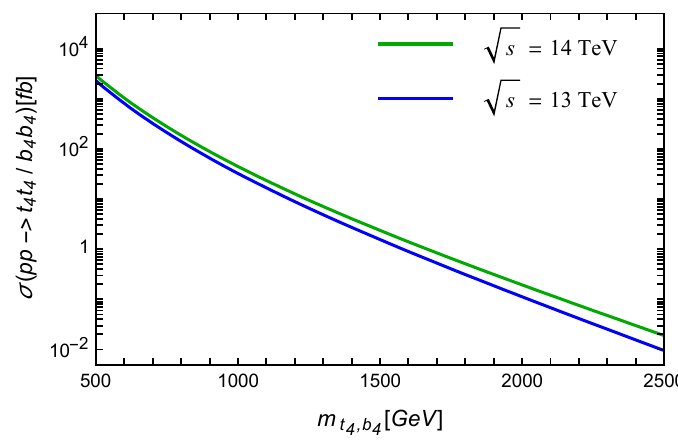
Figure 4 . Production cross section for pair-produced vectorlike top or bottom quarks at the LHC. In green (blue) we show the LO cross section for 14 TeV (13 TeV) center of mass